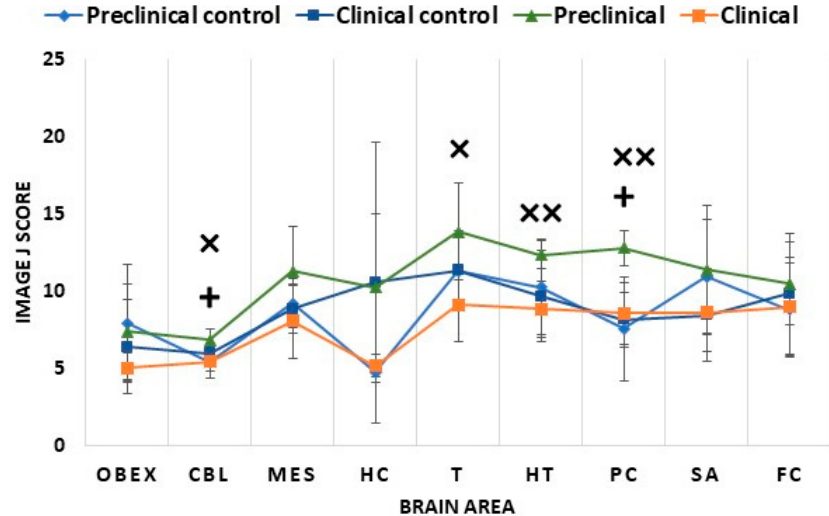
Figure 6. Comparison of 5hmC Image J scores of the studied brain areas in the different mice groups: preclinical control, clinical control, preclinical, and clinical mice. The nine studied areas were the obex, cerebellum (CBL), mesencephalon (MES), hippocampus (HC), thalamus (T), hypothalamus (HT), parietal cortex (PC), septal area/striatum (SA), and frontal cortex (FC). The data are presented as mean values ± SEM. + Significant difference between preclinical control and preclinical mice ( p < 0.05); × significant difference between preclinical and clinical mice ( p < 0.05); ×× significant difference between preclinical and clinical mice ( p < 0.01).